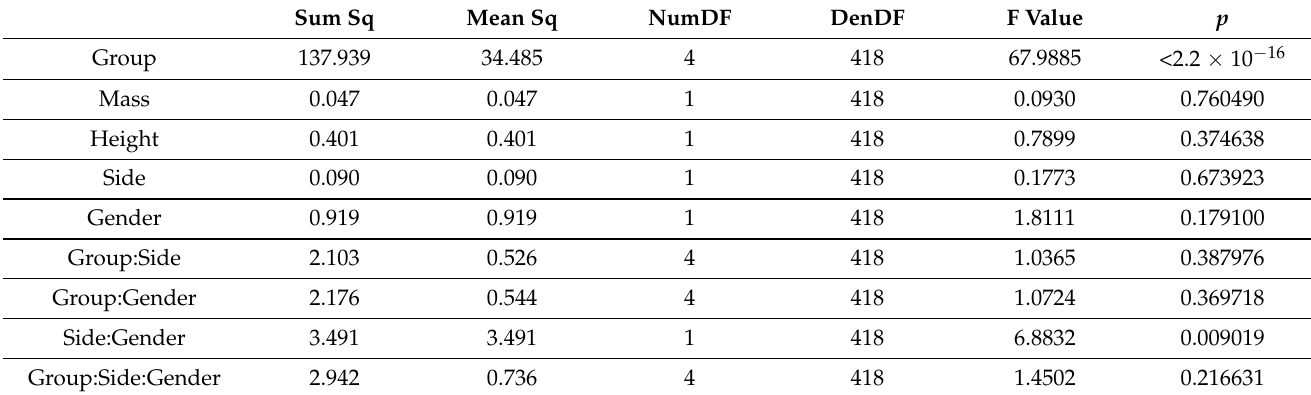
Figure 2. VAG signals’ representative sample wave-forms and their recurrence. The RR approximately linearly decreases with age (main effect of GROUP F ( 4, 418 ) = 67.99, p < 0.001). The post-hoc analysis showed that there were statistically significant differences ( p < 0.01) in all comparisons except the 5th–6th decade. In Table 3, the ANCOVA results were presented and illustrated with Figure 3. The smaller the values of the sample entropy, the greater the regularity of the signal or the greater the number of extreme values. Statistical analysis was performed on the sum values across all temporal scales. Table 3. Type III analysis of variance table with Satterthwaite’s method for RR .